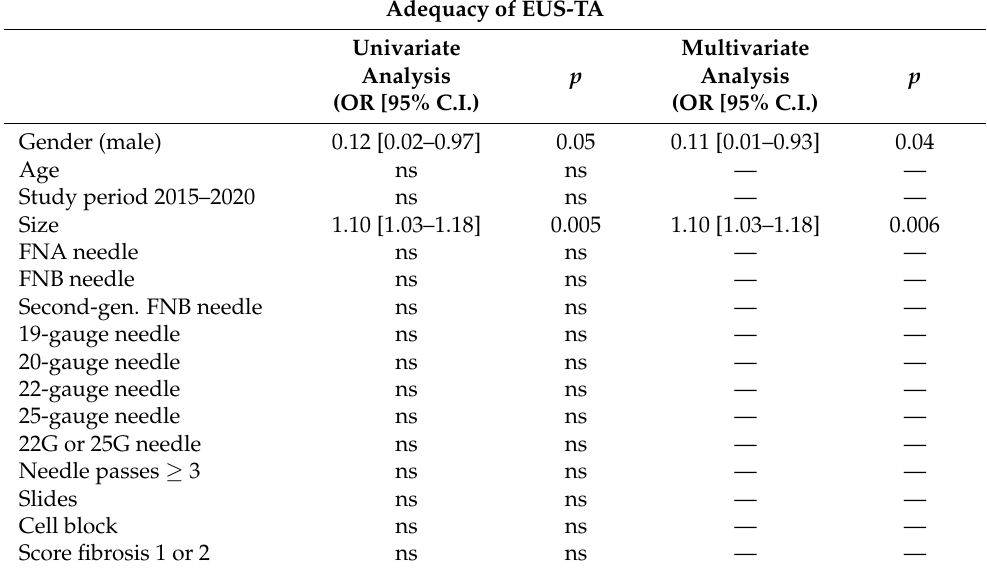
Table 5. Variables related to EUS-guided tissue acquisition specimen adequacy for solid pancreatic tumors located in the neck, body, and tail.